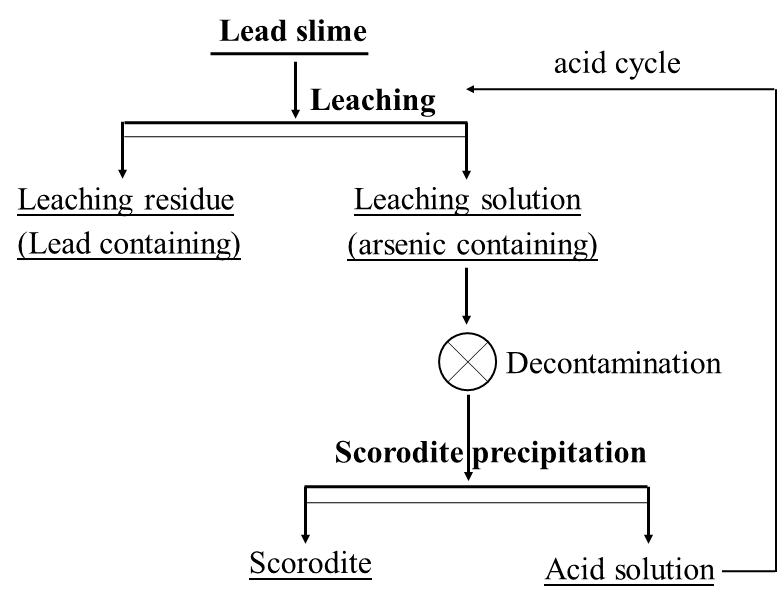
Figure 3. Schematic flowsheet for the treatment of lead slime.